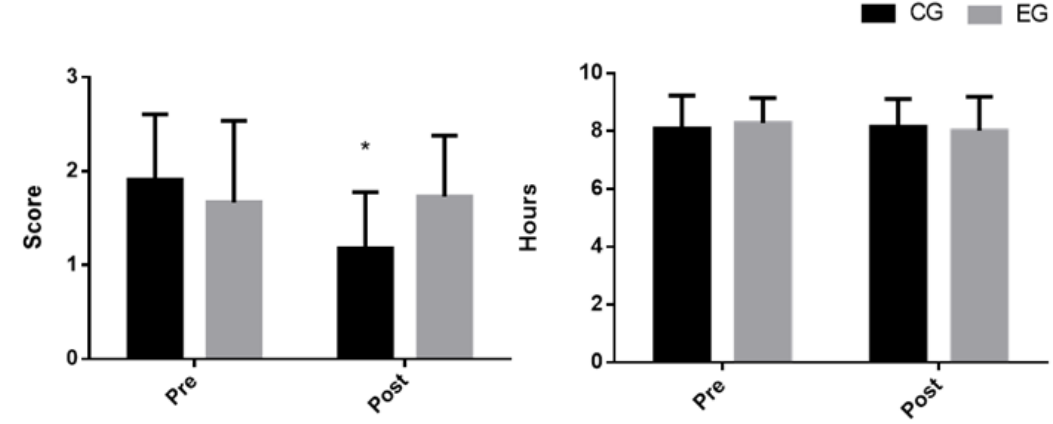
Figure 1. E ff ects of tryptophan and magnesium-enriched Mediterranean diet on (a) sleep duration rating (left) and (b) sleep duration (h) (right); *: p value < 0.01; CG: control group; EG: experimental group. Table 2. Body Shape Questionnaire (BSQ), State–Trait Anxiety Inventory (STAI), Profile of Mood States (POMS), and Eating Attitudes Test-26 (EAT-26) results for control and experimental groups.